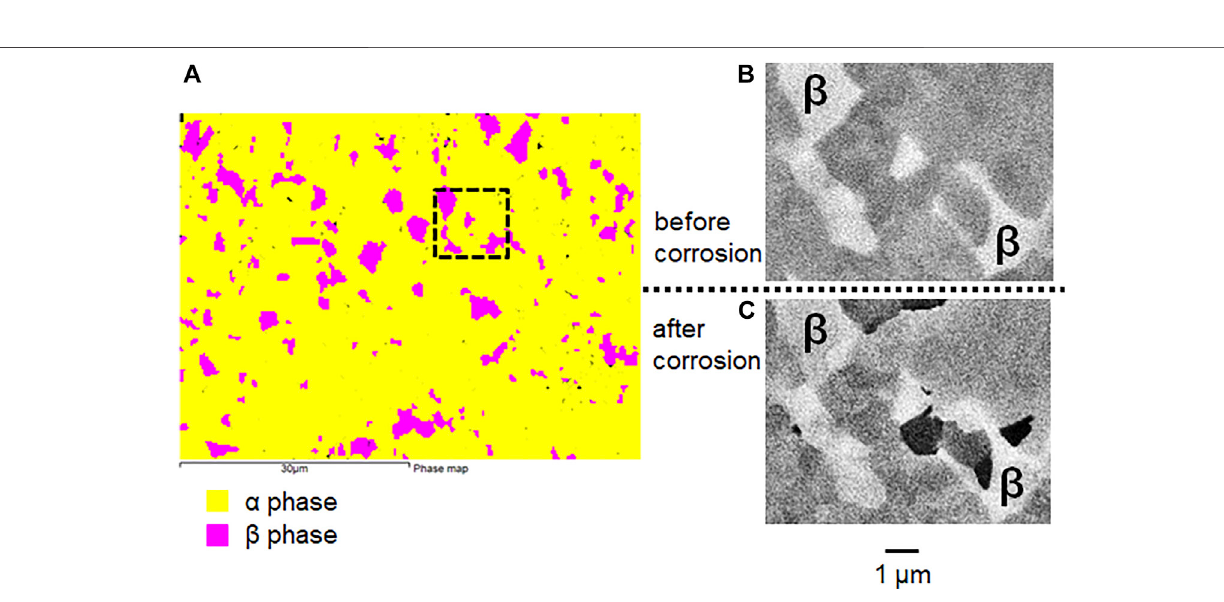
Frontiers in Materials |